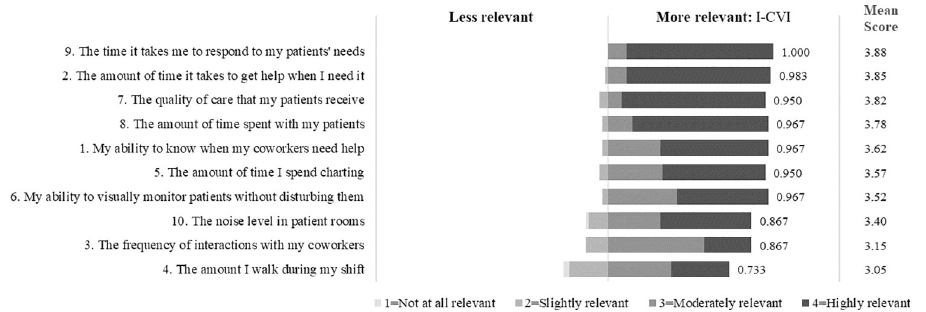
Fig 4. Phase 2 relevance of CARE items response. Frequency, relevance I-CVI, and mean score response.